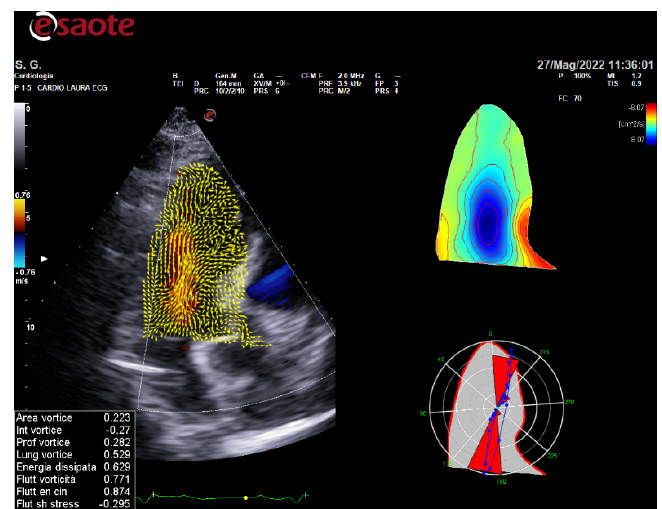
Figure 1. Example of Vortex acquisition and analysis in subjects after renal transplantation and mild hypertension. Caption: the blue colour is the main central flow in the LV chamber. The forces distributions are represented by the red angular flow.